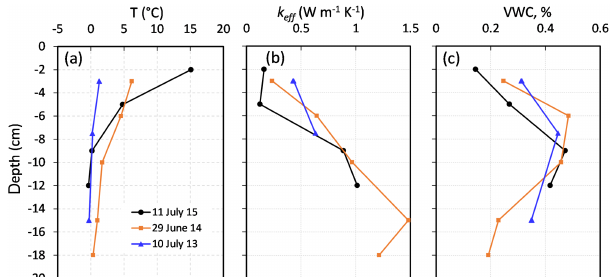
Figure 4. Vertical profiles of soil physical variables in pits dug in the polygon where our instrument station is located, during summers 2013 to 2015. (a) Temperature; (b) thermal conductivity; (c) volu- metric liquid water content.